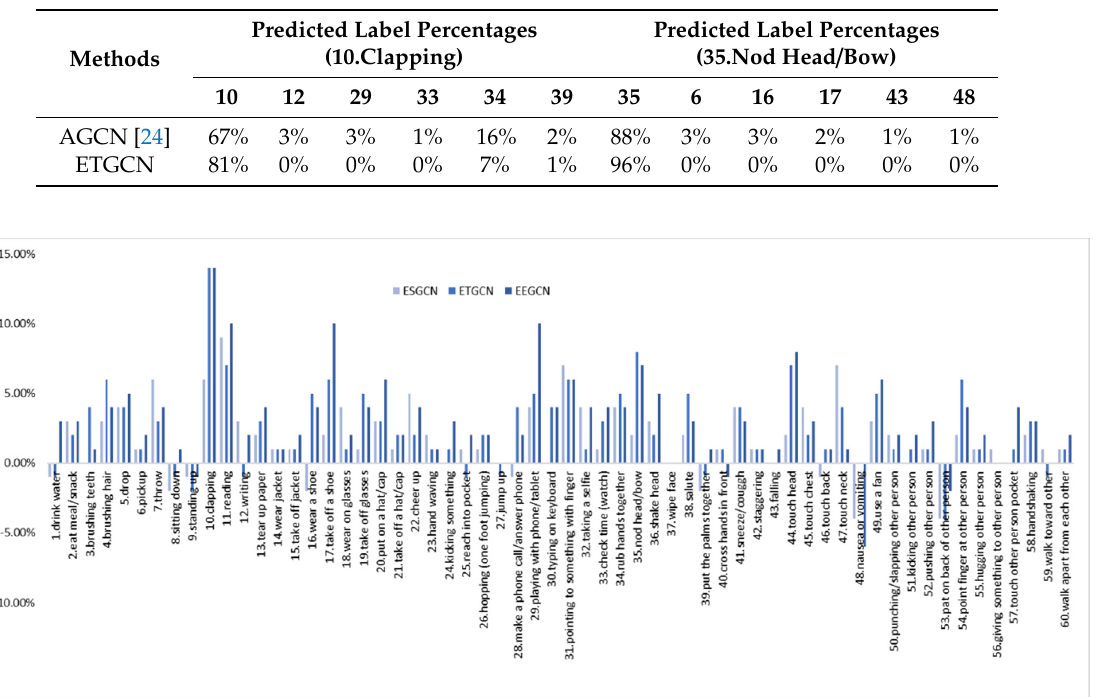
Figure 7. The improvements of each action in ESGCN, ETGCN, and EEGCN over AGCN [24].